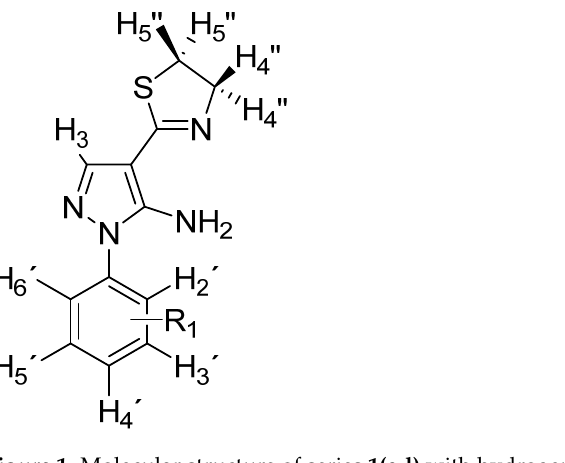
Figure 1. Molecular structure of series 1(a-l) with hydrogen atoms highlighted.